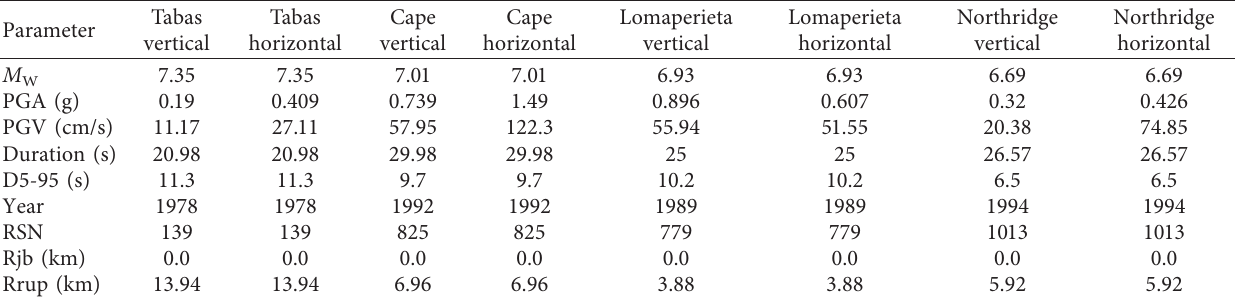
Table 8: Specifications of selected earthquake record.